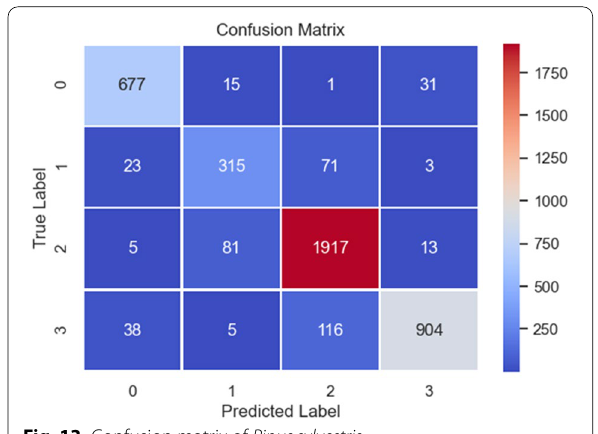
Fig. 13 Confusion matrix of Pinus sylvestris